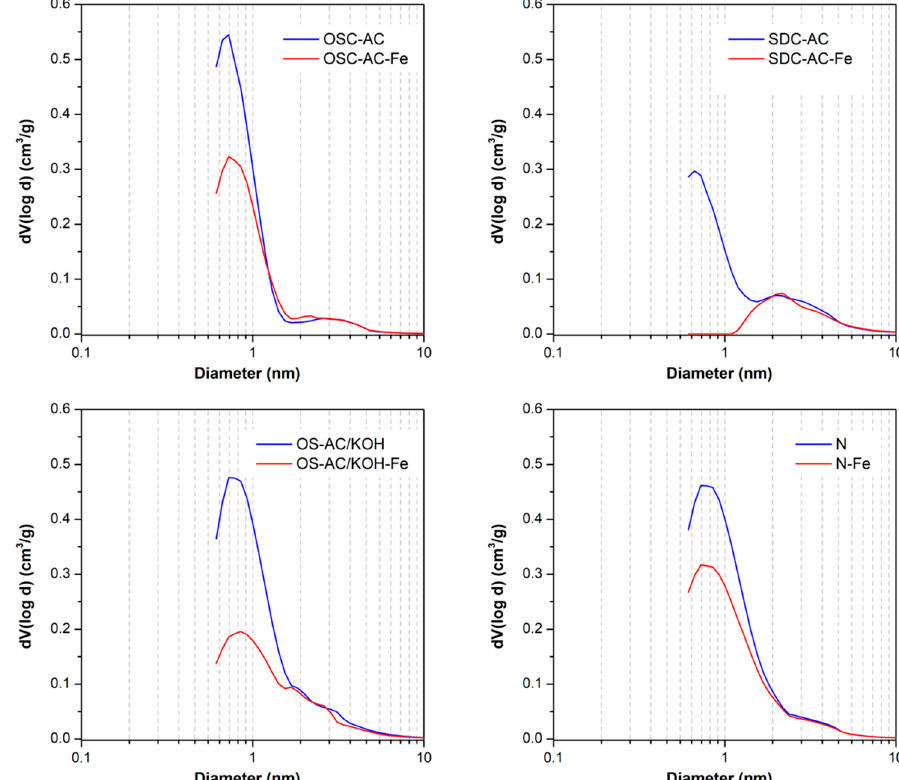
Figure 3. Pore size distribution obtained by Quenched Solid Density Functional Theory (QSDFT) applied to N 2 -adsorption isotherms for selected activated carbon supports and Fe-derivative catalysts: e ff ect of Fe-impregnation.